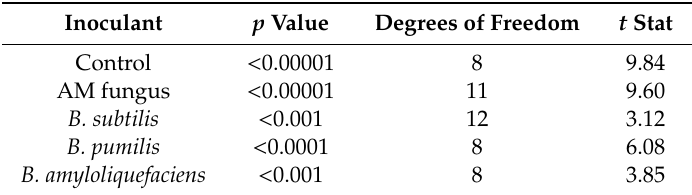
Table 1. Summary output of two-tailed, unequal variance paired t -tests between tillage treatments and each respective inoculant